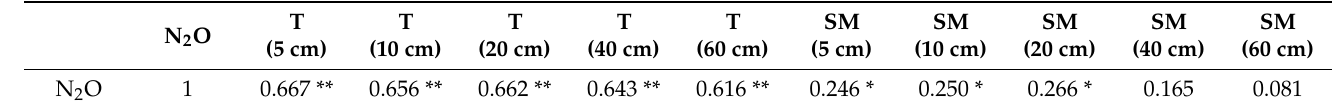
Table 3. Pearson correlation between N 2 O and soil temperature or moisture in different depth in winter wheat field from 1 October 2019 to 1 March